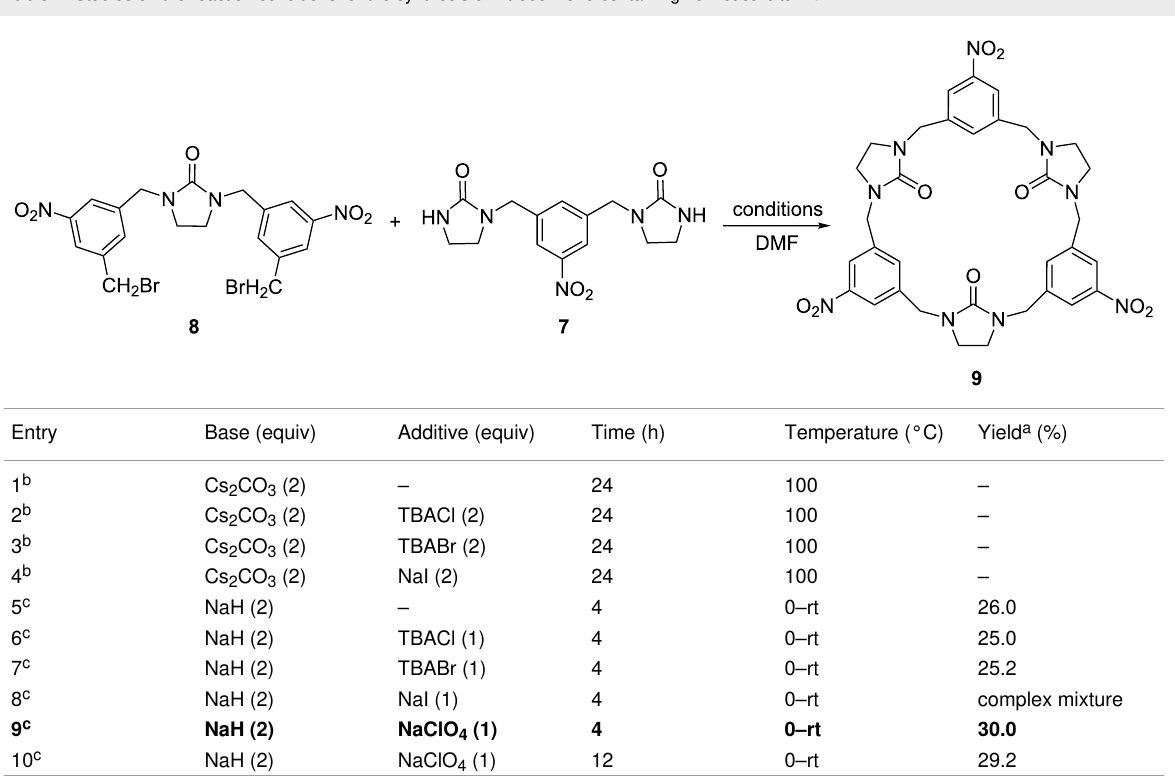
Table 1: Studies on the reaction conditions for the synthesis of nitrobenzene-containing hemicucurbituril 9 .